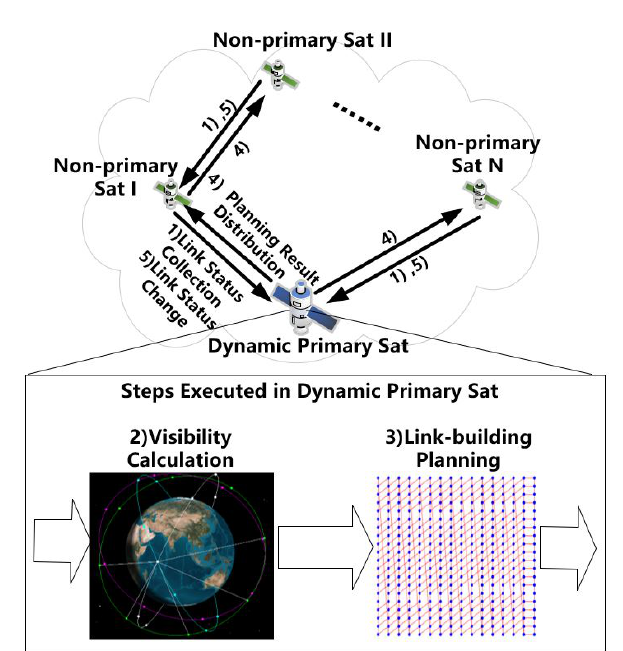
Figure 1. Satellite onboard centralized ISL-building planning